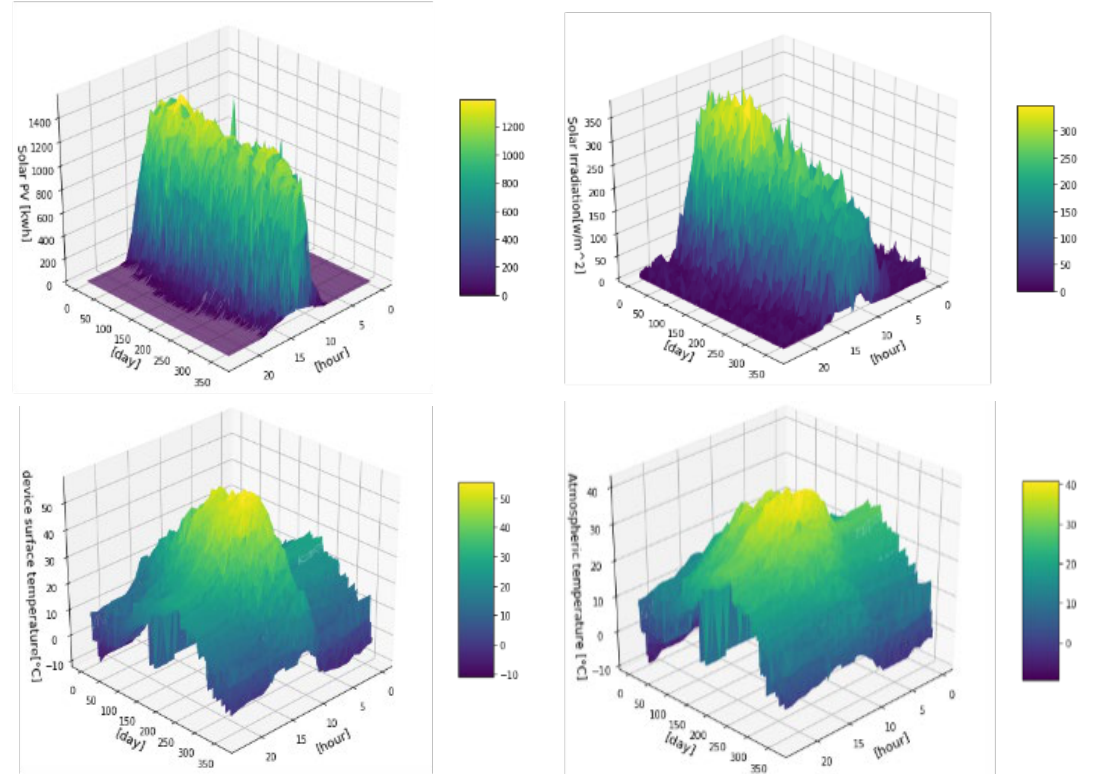
Figure 6. 3D view of four types of input data of adjacent days in Yeonseong-gun, South Korea (1 January 2015 to 31 October 2018).